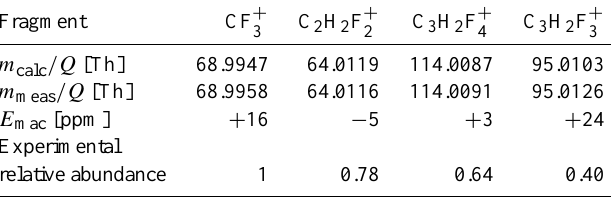
Table 1. Experimentally determined fragmentation and measured ion masses of fragments from HFC-1234yf (CH 2 CFCF 3 ) in an air sample from a parking lot. Approximate HFC-1234yf mixing ratio in this sample: 3–4ppt. For identification, the maximum intensity spectrum was chosen within the chromatographic peak.